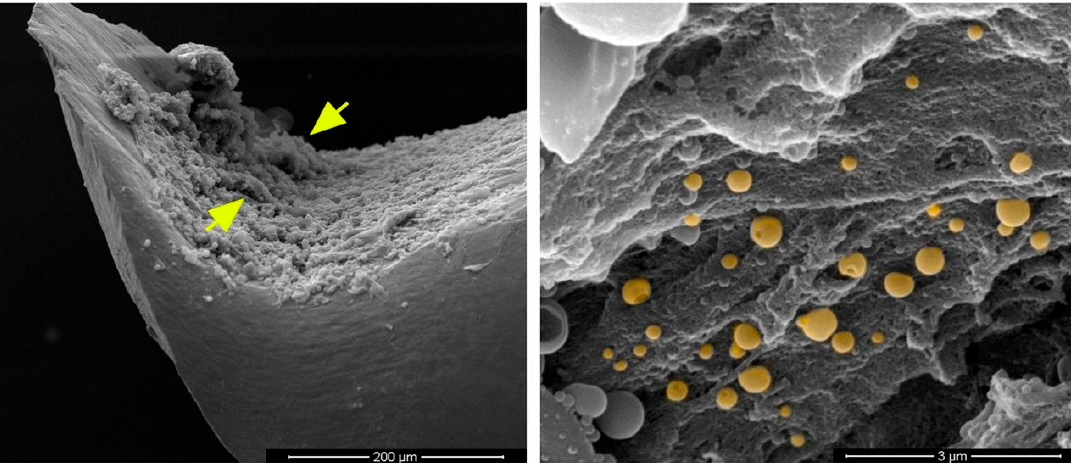
Figure 3. Scanning electron microscopy: Biofilm on the surface of an orthopedic implant [12]. adopted from Heim et al. [12].